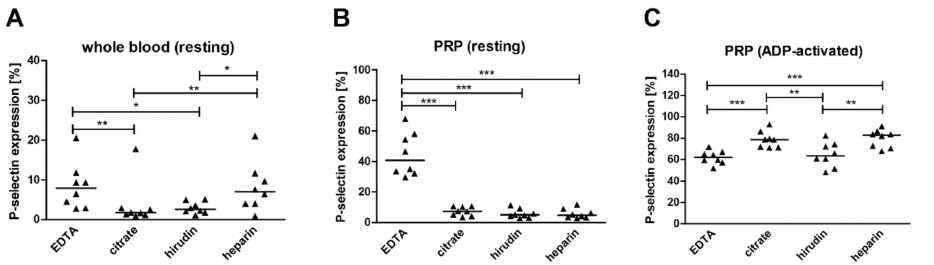
Figure 1. Activation and reactivity of platelets obtained from blood collected on different anticoagu- lants. Data presented as individual data points with medians (horizontal lines) ( n = 8) for P-selectin expression in ( A ) resting platelets in whole blood, ( B ) resting platelets in PRP and ( C ) ADP-activated platelets in PRP. The significance of differences, as estimated with the bootstrap-boosted Kruskal– Wallis test (10,000 iterations) and the post hoc Conover–Inman test for multivariate comparisons, was: * p < 0.05, ** p < 0.01, *** p < 0.001. We have also observed the impact of EDTA on platelet mitochondrial respiration.